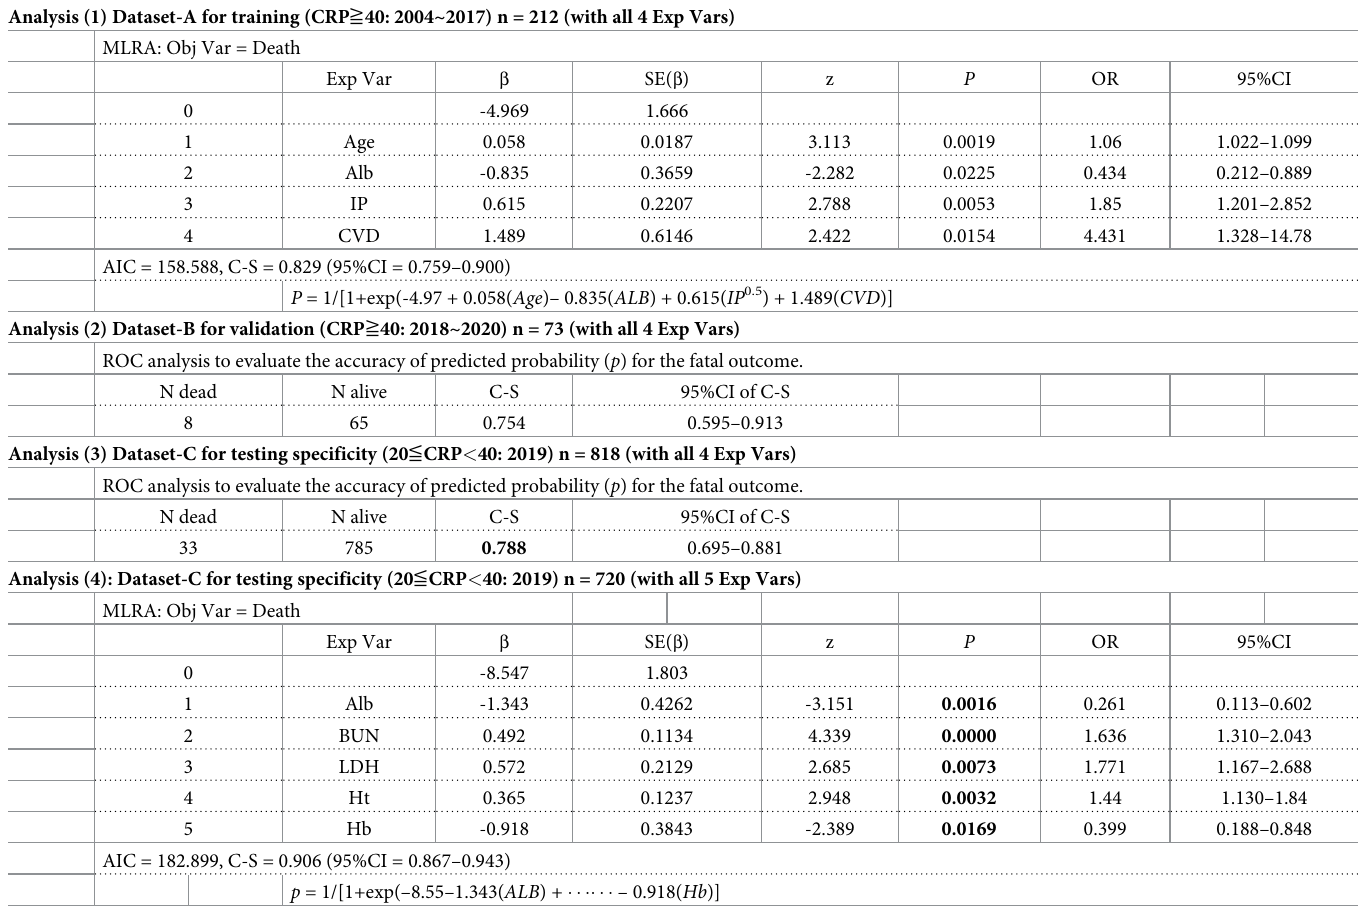
Table 2. Multivariate logistic regression analyses for predicting 72-hour mortality.